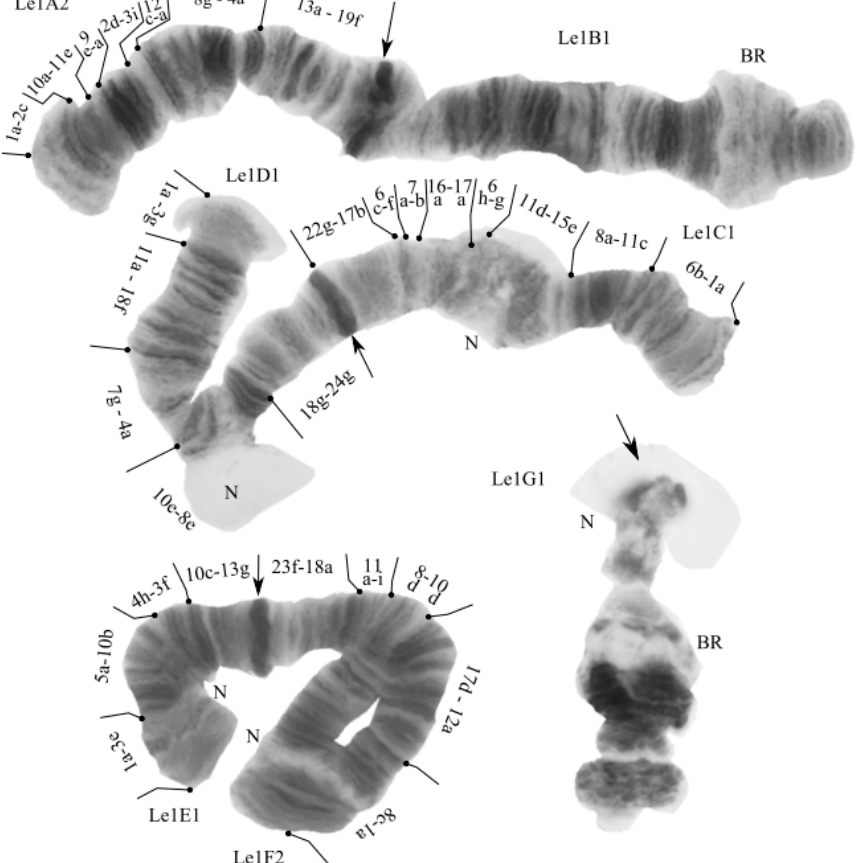
Figure 3. Part of the Chironomus sp. Le1 karyotype from a hybrid of Ch. sp. Le1 × Ch. laetus from the Yamal Peninsula, Russia. Arrows indicate a centromeric bands; Le1A2, Le1B1, etc., genotypic combinations of banding sequences in chromosome arms; BR—Balbiani rings; N—nucleous.